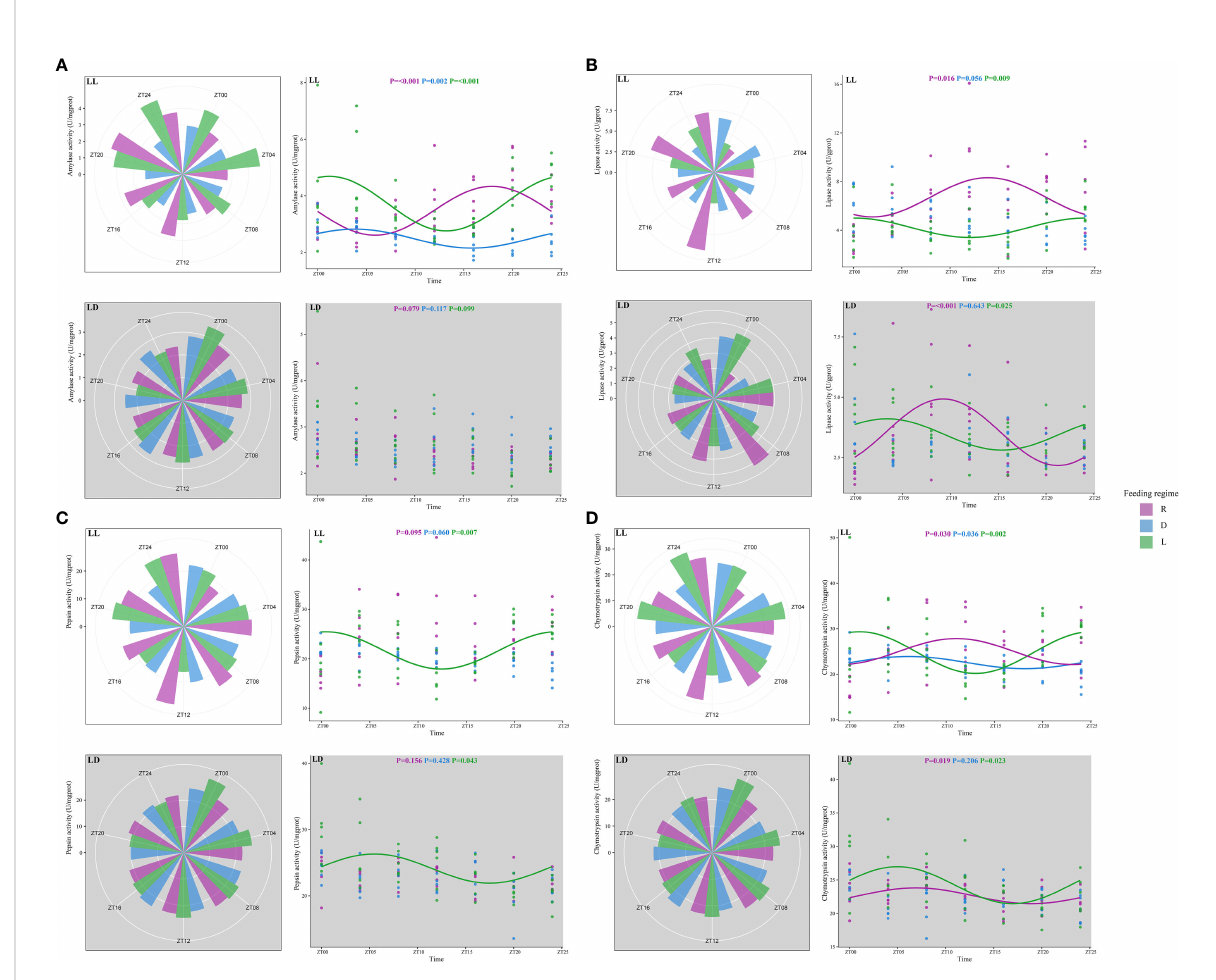
FIGURE 3 Digestive enzyme activity of juvenile Oncorhynchus mykiss under different experimental treatment. (A) . Amylase, (B) . Lipase, (C) . Pepsin, (D) Chymotrypsin. The cosine curve denotes the presence of rhythmic oscillations ( P <